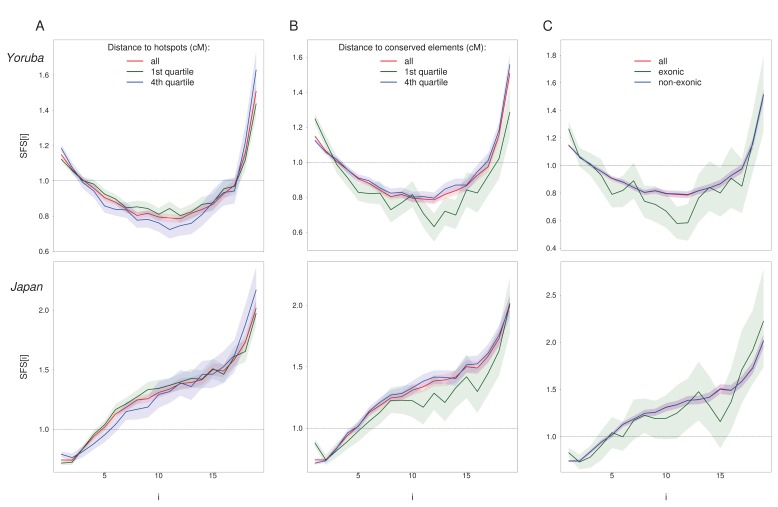
Impact of covariates on the normalized unfolded SFS for WW + SS sites with RR ≥ 1.5 cM/Mb (in red) on Yoruba (top) and Japan (bottom) population.(A) Recombination distance to hotspots (i.e. RR > 10 cM/Mb). SFS of sites belonging to the first (d ≤ 0.01647 cM, in green) and fourth quartile (d ≥ 0.08728 cM, in blue) are significantly different from the SFS computed on all SNPs (p=0.017 and p=0.005 respectively for Yoruba, p<10−3 for Japan, see Materials and methods). (B) Recombination distance to PhastCons conserved elements (see Materials and methods for definition). SFS of sites belonging to the first (d ≤ 0.0000543 cM, in green) and fourth quartile (d ≥ 0.0024580 cM, in blue) are significantly different from the SFS computed all SNPs (p<10−3 for all but the 4th quartile of Yoruba population for which p=0.003). (C) The SFS of exonic sites (green) are significantly different from that computed on all SNPs (p=0.004 and p<10−3 for Yoruba and Japan resp.) while the SFS of non-exonic sites (blue) are not different from the SFS of all SNPs (p=1). The SNPs furthest to hotspots have both an enrichment for singletons and high-frequent variants, whereas the SNPs closest to conserved elements and exonic sites have only an enrichment for singletons. Shaded areas correspond to 95% CI obtained by a block-bootstrap approach (see Materials and methods).